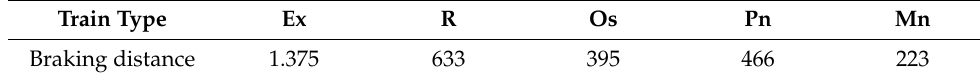
Table 2. Determined braking distances for ETCS L3 level